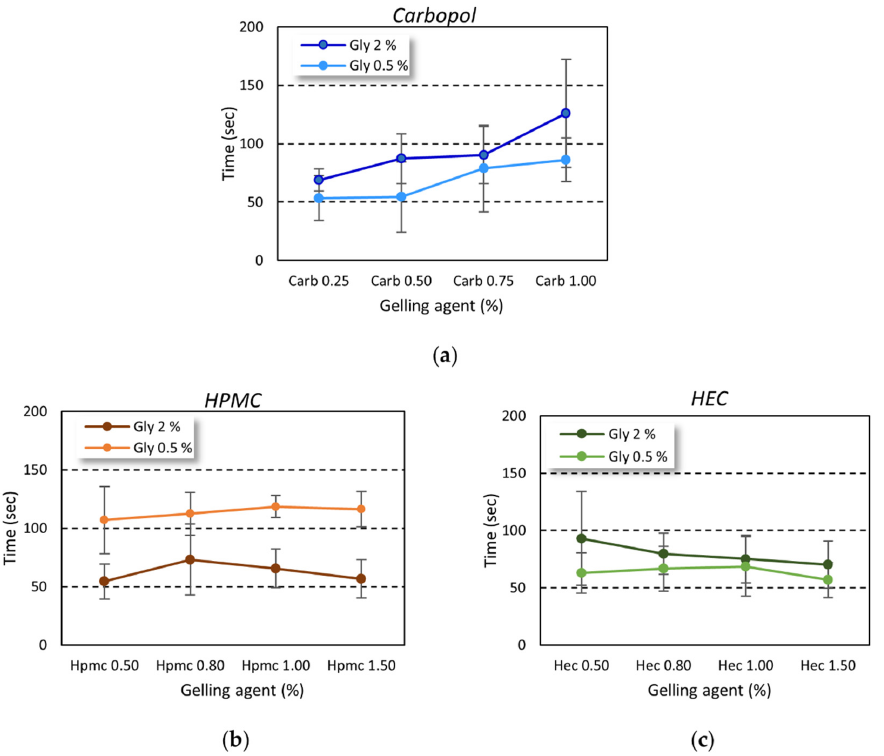
Figure 6. The gel dry time by rubbing. The results are reported as time needed to achieve complete drying by rubbing a known amount of gel on the hands of volunteers. ( a ) Carbopol-based gels; ( b ) HPMC-based gels; ( c ) HEC-based gels.